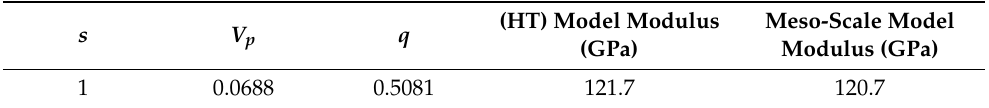
Table 7. Parameters used in the Halpin–Tsai (HT) model and the modulus of elasticity obtained from the meso-scale